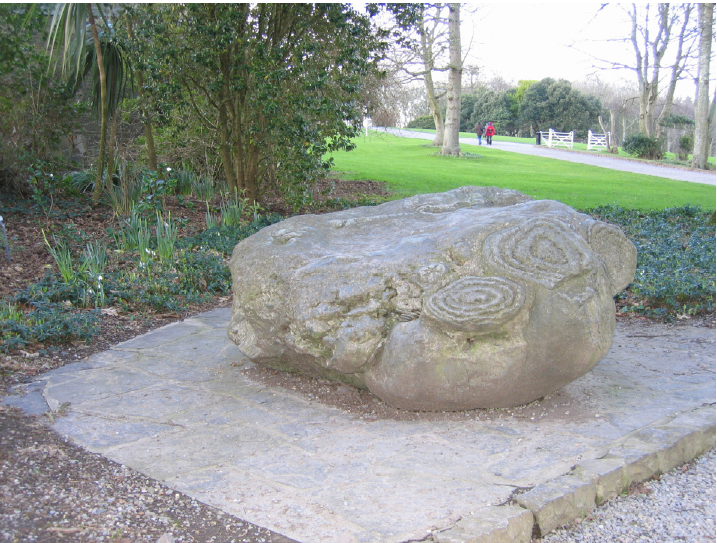
Figure 5. Ardgillan House Boulder, County Dublin: weathered Ordovician pillow lavas. Lambay Island, situated off the coast north of County Dublin [14] is the eroded